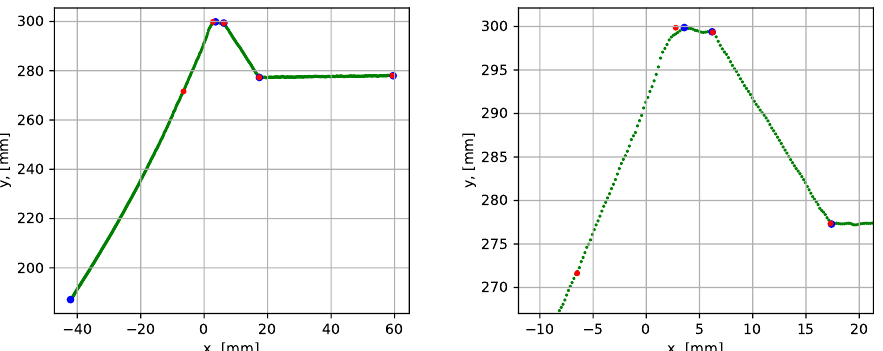
Figure 19. Parametrization results with groove corner points for dataset 3. The blue dots show the result before the iterative error elimination procedure and the red dots show after. A close-up of the graph is shown to the right.